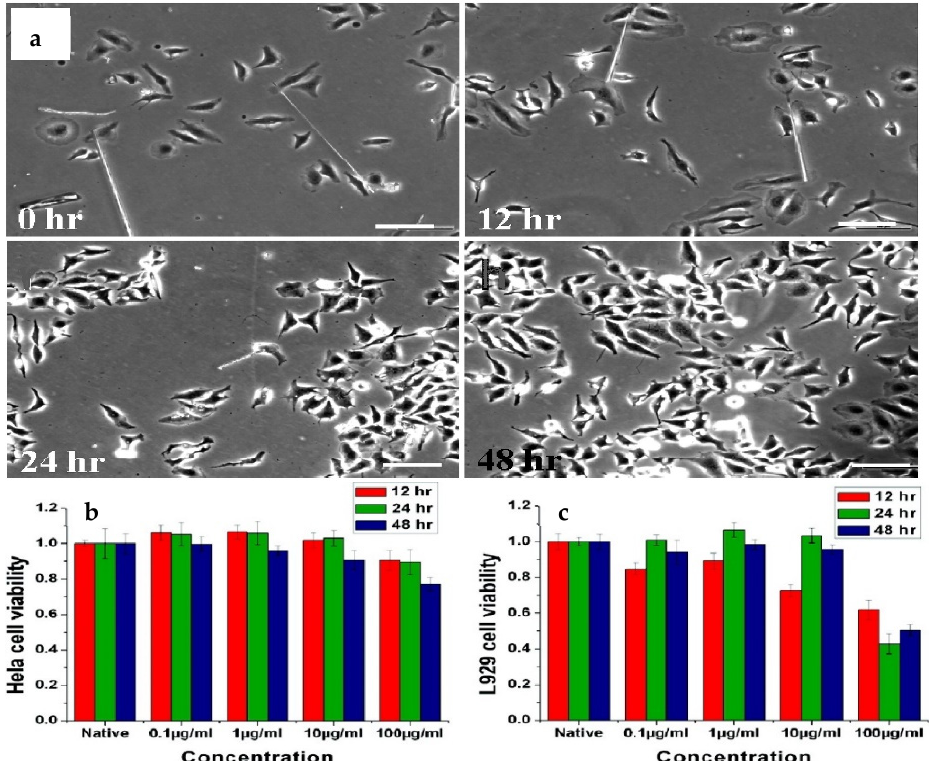
Figure 3. Effect of ZnO NWs on the growth and reproduction of cells as a function of time, and cell viability tested by MTT method as a function of ZnO NW concentration and time, reported by Li et al. [26] ( a ) Hela cells cultured with ZnO nanowires in solution after growing for 0, 12, 24, and 48 h, respectively. Cell viability as a function of ZnO NW concentration and time: ( b ) cell viability of Hela cells cultured with different concentrations of ZnO NWs for 12 h, 24 h, and 48 h; ( c ) viability of L929 cells cultured with different concentrations of ZnO NWs for 12 h, 24 h, and 48 h.